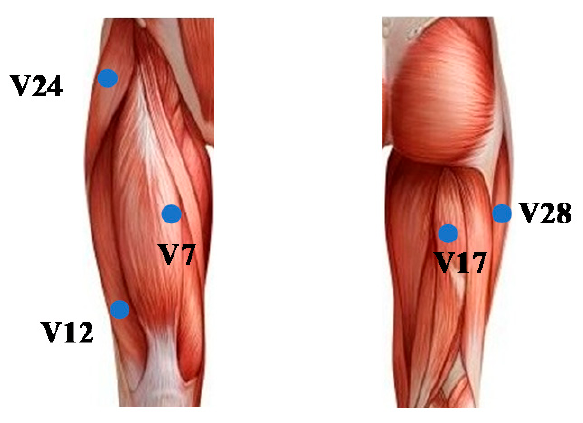
Figure 16. Key nodes’ distribution.